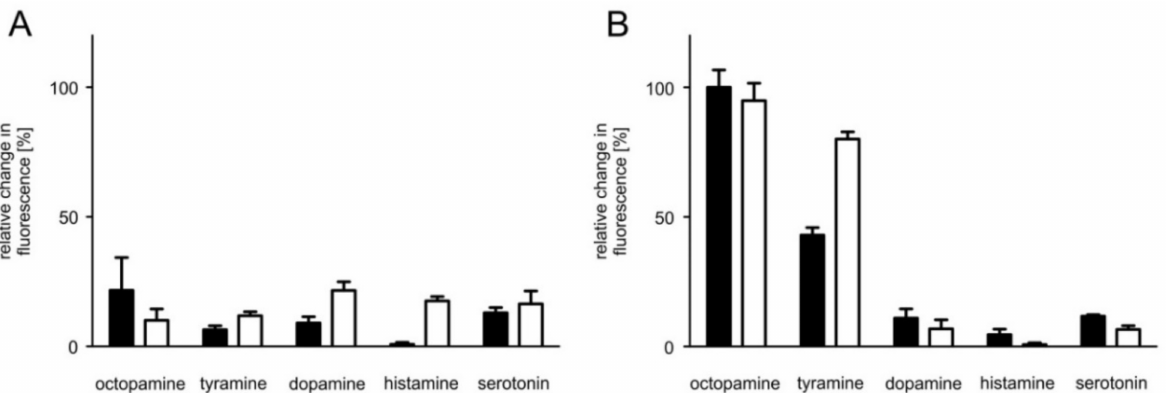
Figure 5. Biogenic amine evoked responses in flpTM and PaOct β 2R-HA-expressing cells. The relative change in fluorescence (corresponding to the amount of cAMP produced) in ( A , B ) is given as the percentage of the value obtained in the presence of 0.1 µ M octopamine in flpTM + PaOct β 2R-HA cells (=100%). All measurements were performed in the presence of 100 µ M 3-isobutyl-1-methylxanthine (IBMX). Biogenic amines were applied at two concentrations (0.1 µ M (black bar) and 1 µ M (white